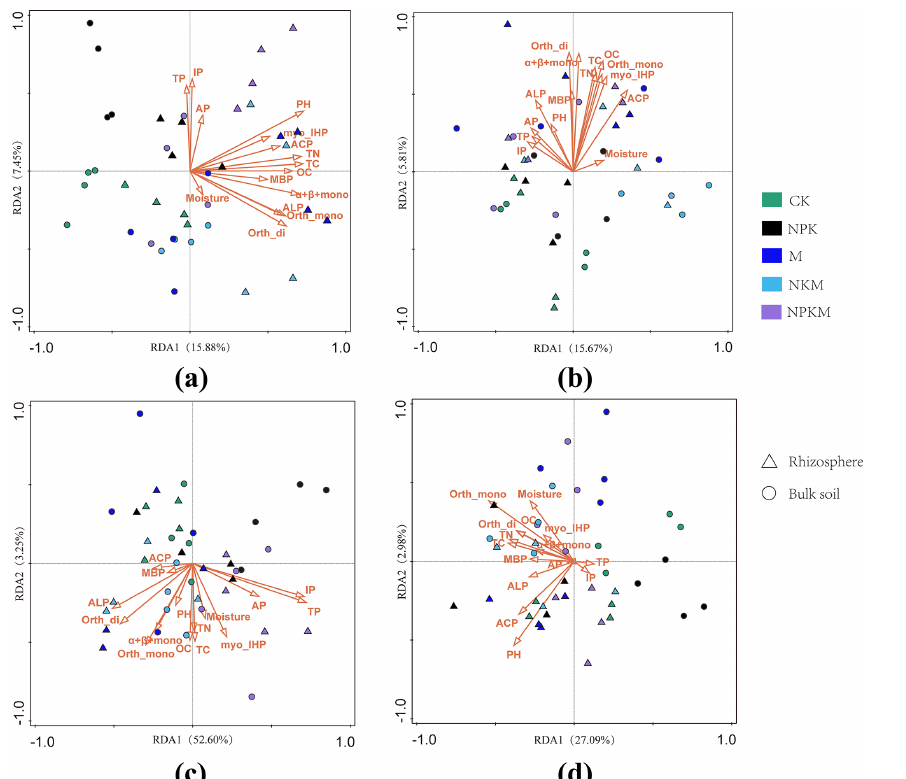
Figure 7. Correlations between soil properties and the community structure of (a) total bacteria, (b) total fungi, (c) phosphorus-solubilizing bacteria and (d) phosphorus-solubilizing fungi as determined by redundancy analysis (RDA). MBP – microbial biomass phosphorus; TP – total phosphorus; IP – inorganic phosphorus; AP – available phosphorus; Orth-mono –orthophosphate monoester; Orth-di – orthophosphate diesters; Myo-IHP – myo-Inositol hexakisphosphate; α + β + mono – α - and β -glycerophosphates and mononucleotides; ACP – activity of acidic phosphatase; ALP – activity of alkaline